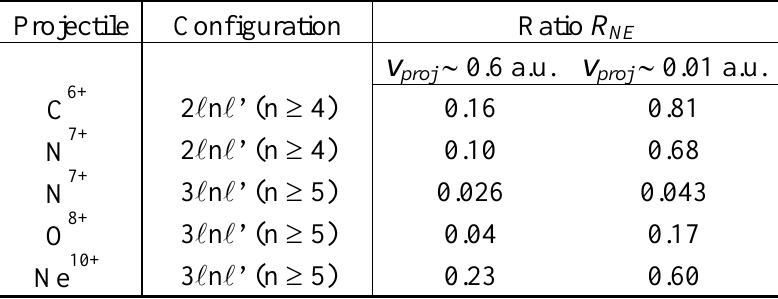
Table 2. Contribution of non equivalent electron configuration to total double electron